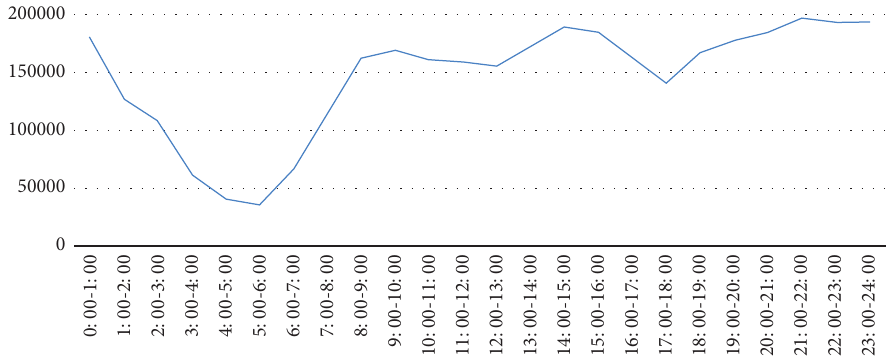
Figure 8: 24-hour travel frequency in